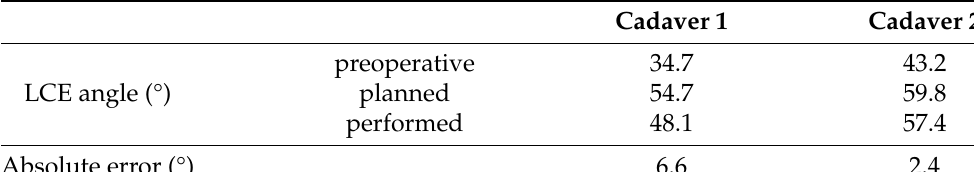
Table 3. 2D results of the AR guided fragment reorientation.